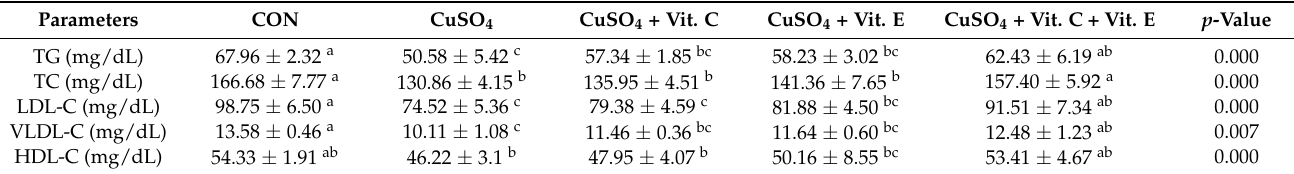
Table 6. Effect of single or combined supplementation of vitamin C and E on the lipid profile of broiler chickens at the end of the 6th week (Mean ± SD, n =